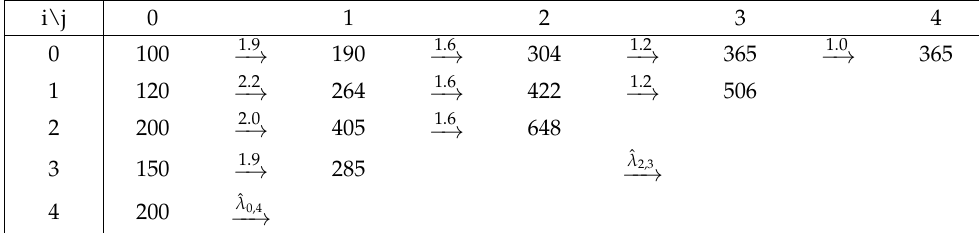
Table 6. Development factors